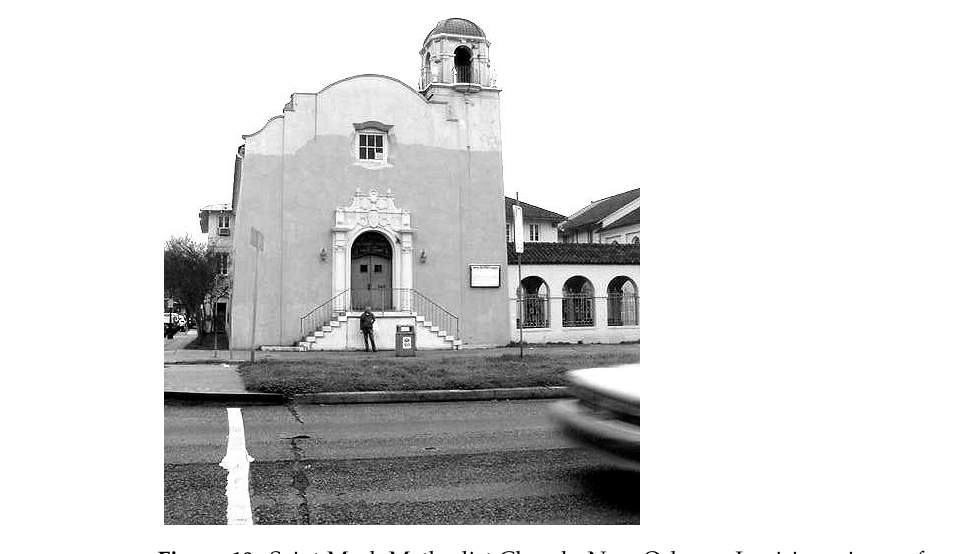
Figure 10. Saint Mark Methodist Church, New Orleans, Louisiana; image from the website http://www.neworleanschurches.com/stmarkfc/stmarkfc.htm (accessed on 28 June 2018); Image credit John and Kathleen DeMajo. June 2017.